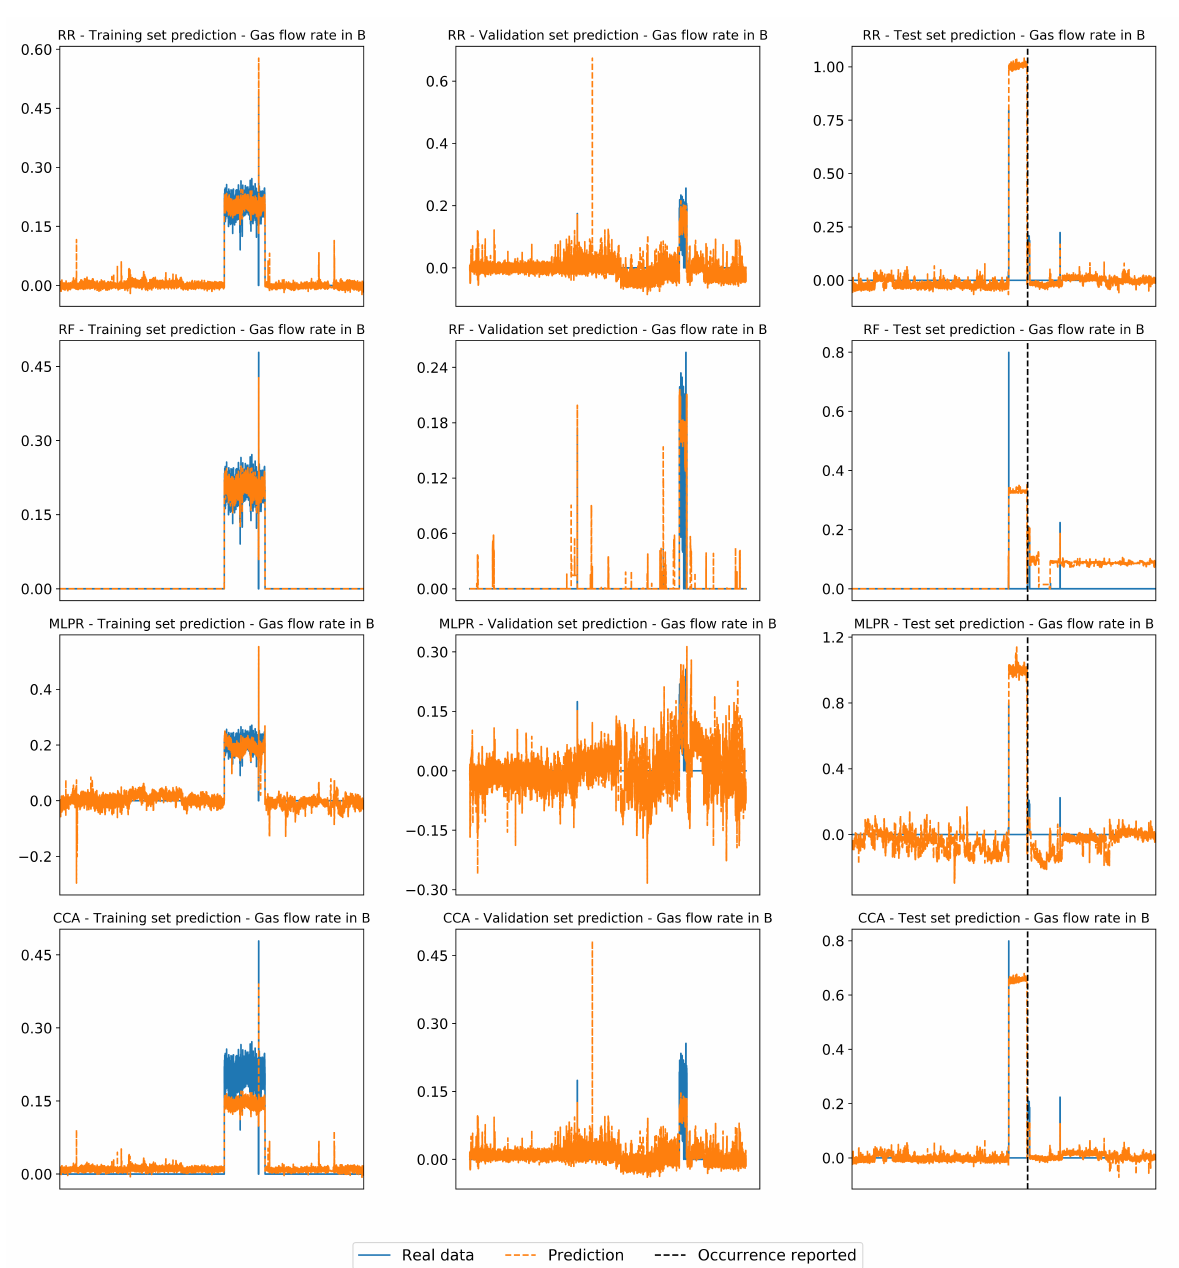
Figure 2. Regressors prediction for dimensionless Gas flow rate in fiscal meter 02B (Section A) along Fault-FI when the PCMCI algorithm (partial correlation) was used as the variable selection